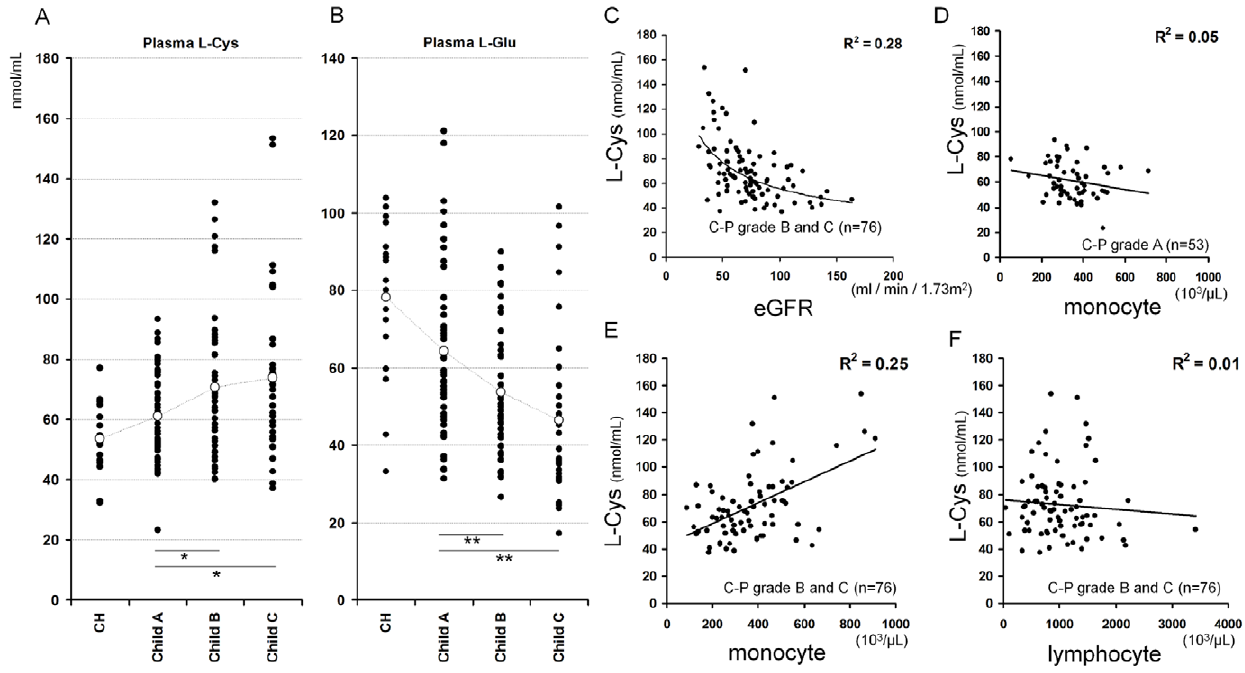
Figure 1. The counts of peripheral monocyte were increased in association with plasma L-Cystine in patients with advanced cirrhosis. A, B, The concentrations of plasma L-Cys in patients with cirrhosis was increased and that of plasma L-Glu was decreased acccording to Child-Pugh grade. The levels of plasma L-Cys and L-Glu in patients with cirrrhosis (n=130) were measured using HPLC and classfied by the Child- Pugh classfication. C, Nonliner regression model was used to model variation in plasma L-Cys and eGFR. D, E,F, Linear regression model was used to model variation in plasma L-Cys and monocyte and lymphocyte counts. Individual correlations between plasma L-Cys levels and monocyte counts in patients with early cirrhosis (D), that in patients with advanced cirrhosis (E), and lymphocyte counts in patients with advanced cirrhosis (F). A,B, **, p , 0.01, _*, p , 0.05 vs Child-Pugh grade A. Statistical significance was determined by one-way ANOVA and Dunnett’s post-hoc procedure. C, D, E, F, R 2 represents coefficient of